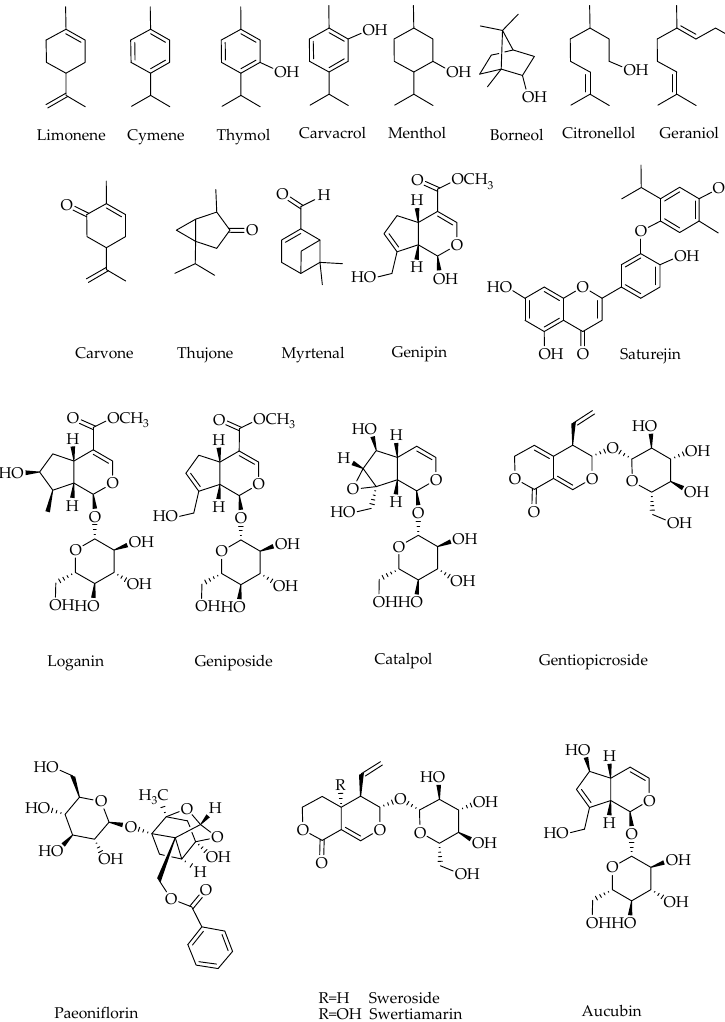
Figure 2. Structures of monoterpenes discussed in this review as antidiabetic agents.